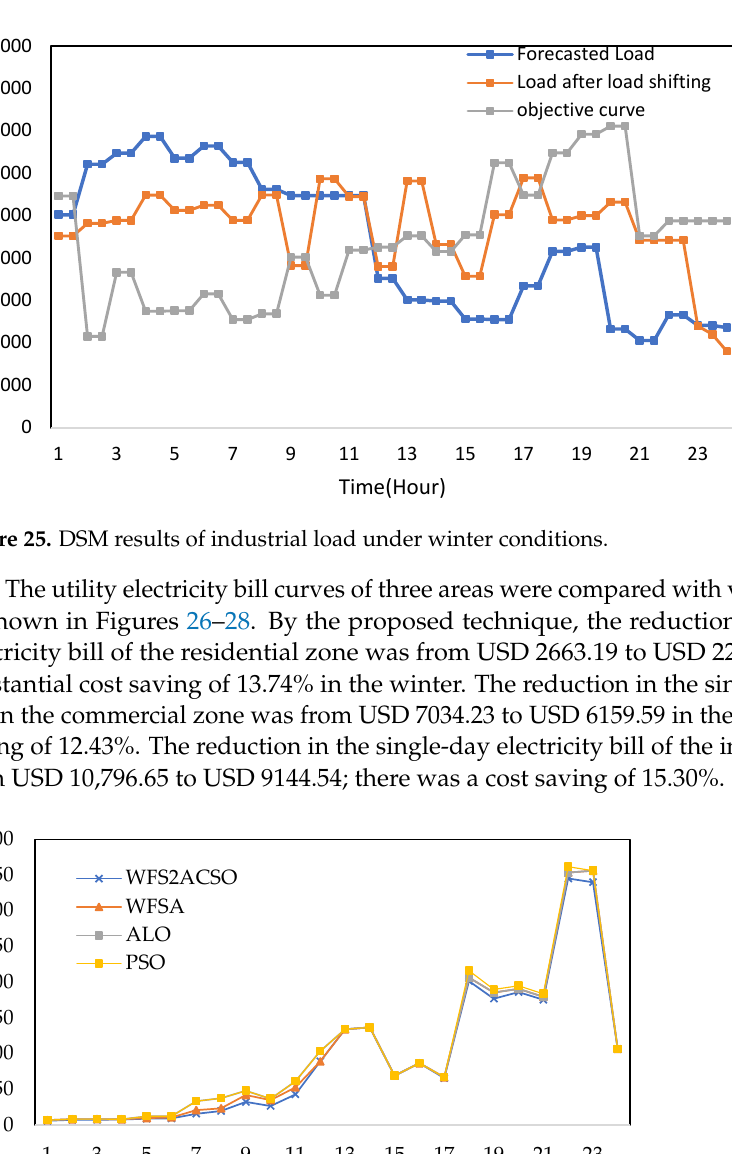
Figure 24. DSM results of commercial load under winter conditions.